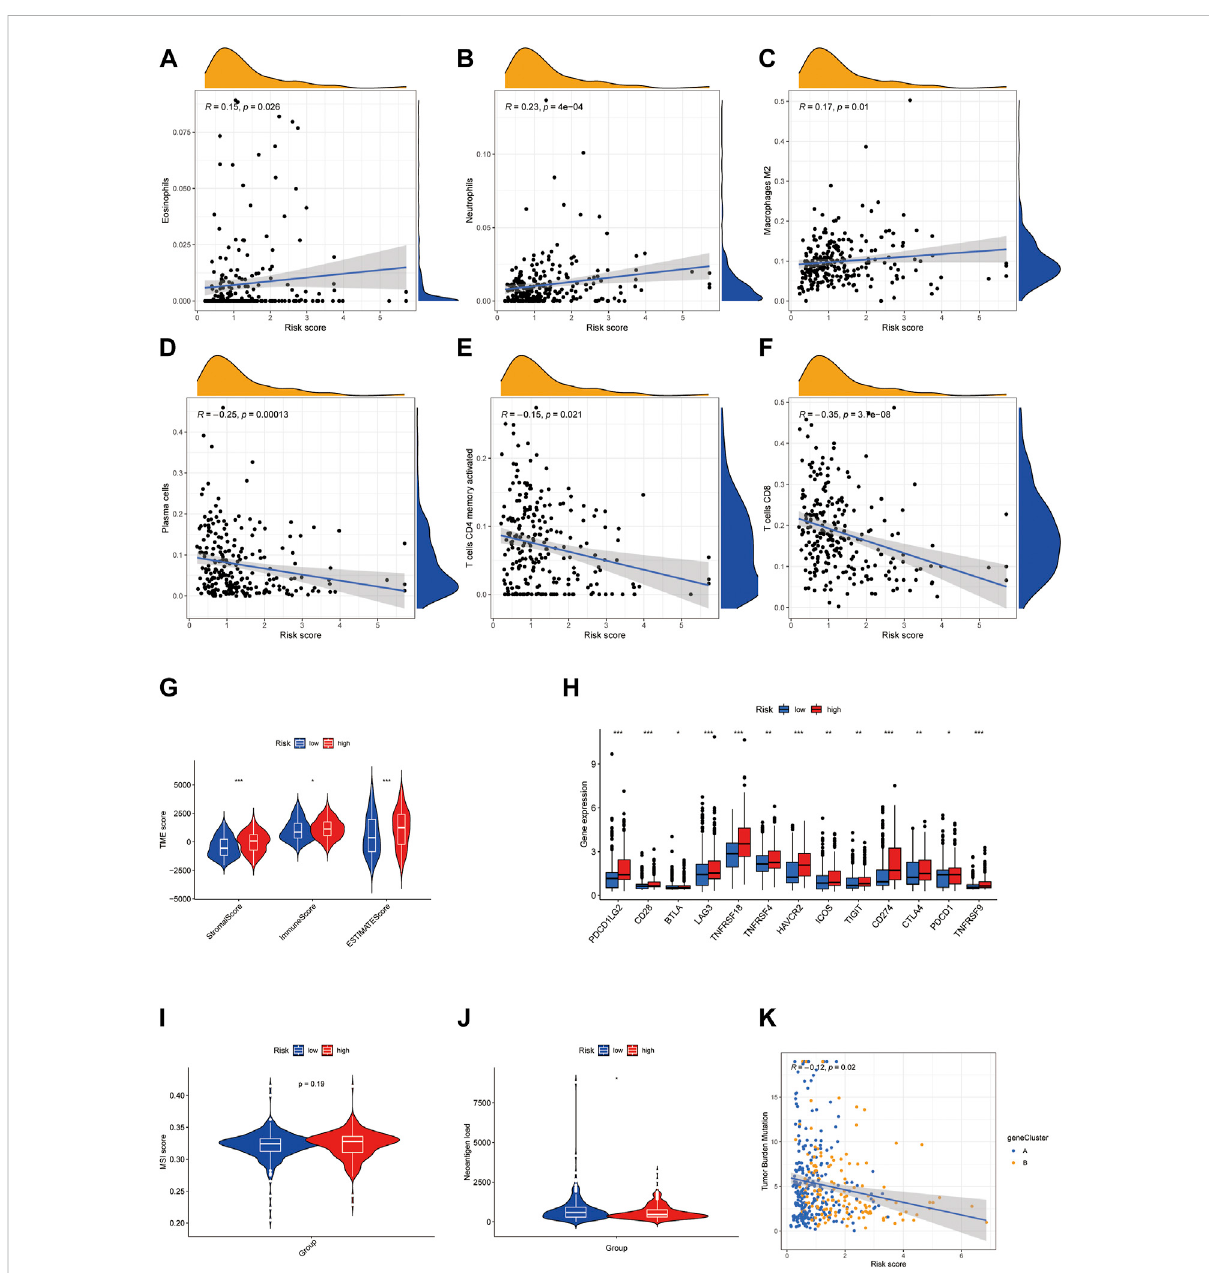
FIGURE 7 High cuproptosis score is associated with immunosuppressing TME in BLCA. (A – F) Correlation of risk score with immune cell in fi ltration analyzed by CYBERSORT. (G) Violin plots showed the difference in stromal score, immune score, and ESTIMATE score in high- and low-risk groups. (H) Boxplots exhibited the expression of the immune checkpoint in high- and low-risk groups. (I,J) Violin plots showed the MSI score (I) and neoantigen load (J) in high- and low-risk groups. (K) Correlation of risk score with tumor mutation burden. * p < 0.05, ** p < 0.01, *** p < 0.001. Abbreviations: TME, tumor microenvironment; BLCA, bladder